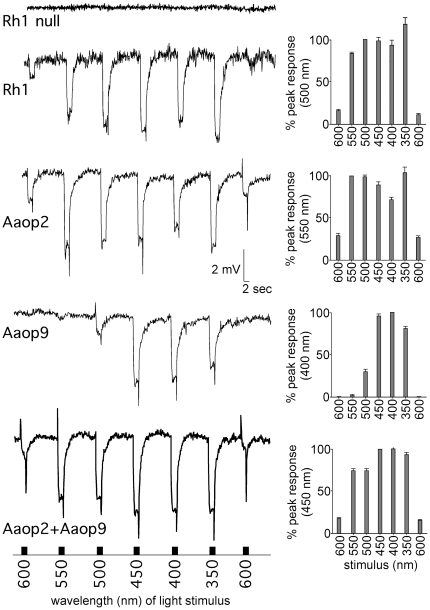
Spectral analysis of Ae. aegypti Aaop9 and Aaop2 rhodopsins in transgenic Drosophila.ERG recordings displaying light response elicited from Drosophila R1–6 cells in ninaEI17 (Rh1 null), Rh1 (wild type), and transgenic Drosophila expressing Aaop2, Aaop9, or both Aaop2 and Aaop9. Two-second light pulses of intensity-equalized lights at 600 nm, 550 nm, 500 nm, 450 nm, 400 nm, 350 nm, and 600 nm were administered at 16 seconds intervals. ERG traces showing a typical response for each genotype is on the left and graphs showing average responses to each wavelength is on the right. Average responses (mean and SEM, sample sizes Rh1 (n = 5), Aaop2 (n = 4), Aaop9 (n = 5), and Aaop2+Aaop9 (n = 4)) are calculated relative to the peak response to visible light. The UV peak for Rh1 (118%) and Aaop2 (104%) exceeded the visible light peak response. The complete genotypes of the flies were Rh1 null: w norpAP24/Y; cn bw; <pRh1-norpA> ninaEI17/<pRh1-norpA> ninaEI17, Rh1: w norpAP24/Y; cn bw; <pRh1-norpA> ninaEI17/+, Aaop2: w norpAP24/Y; cn bw; <pRh1-norpA> ninaEI17/<pRh1-Aaop2> ninaEI17, Aaop9: w norpAP24/Y; <pRh1-Aaop9> cn bw/cn bw; <pRh1-norpA> ninaEI17/ninaEI17, and Aaop2+Aaop9: w norpAP24/Y; <pRh1-Aaop9> cn bw/cn bw; <pRh1-norpA> ninaEI17/<pRh1-Aaop2> ninaEI17.